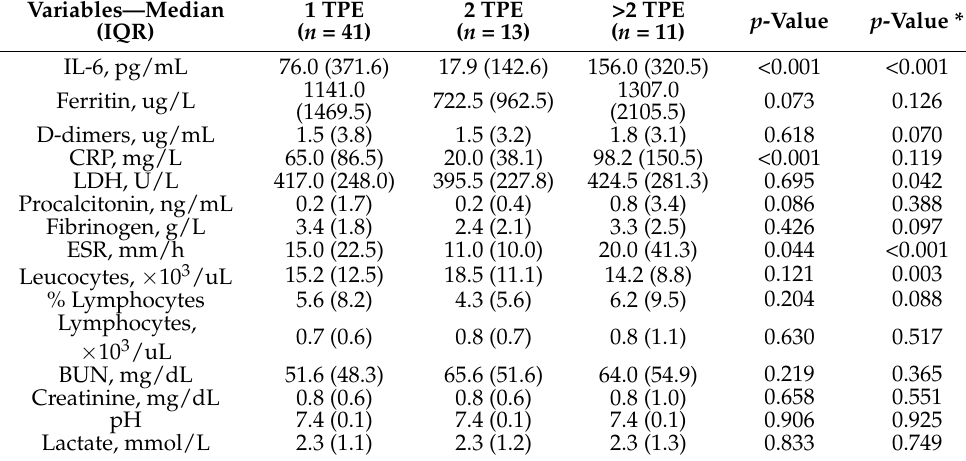
Table 4. Outcomes of patients with severe COVID-19 by number of TPE sessions.